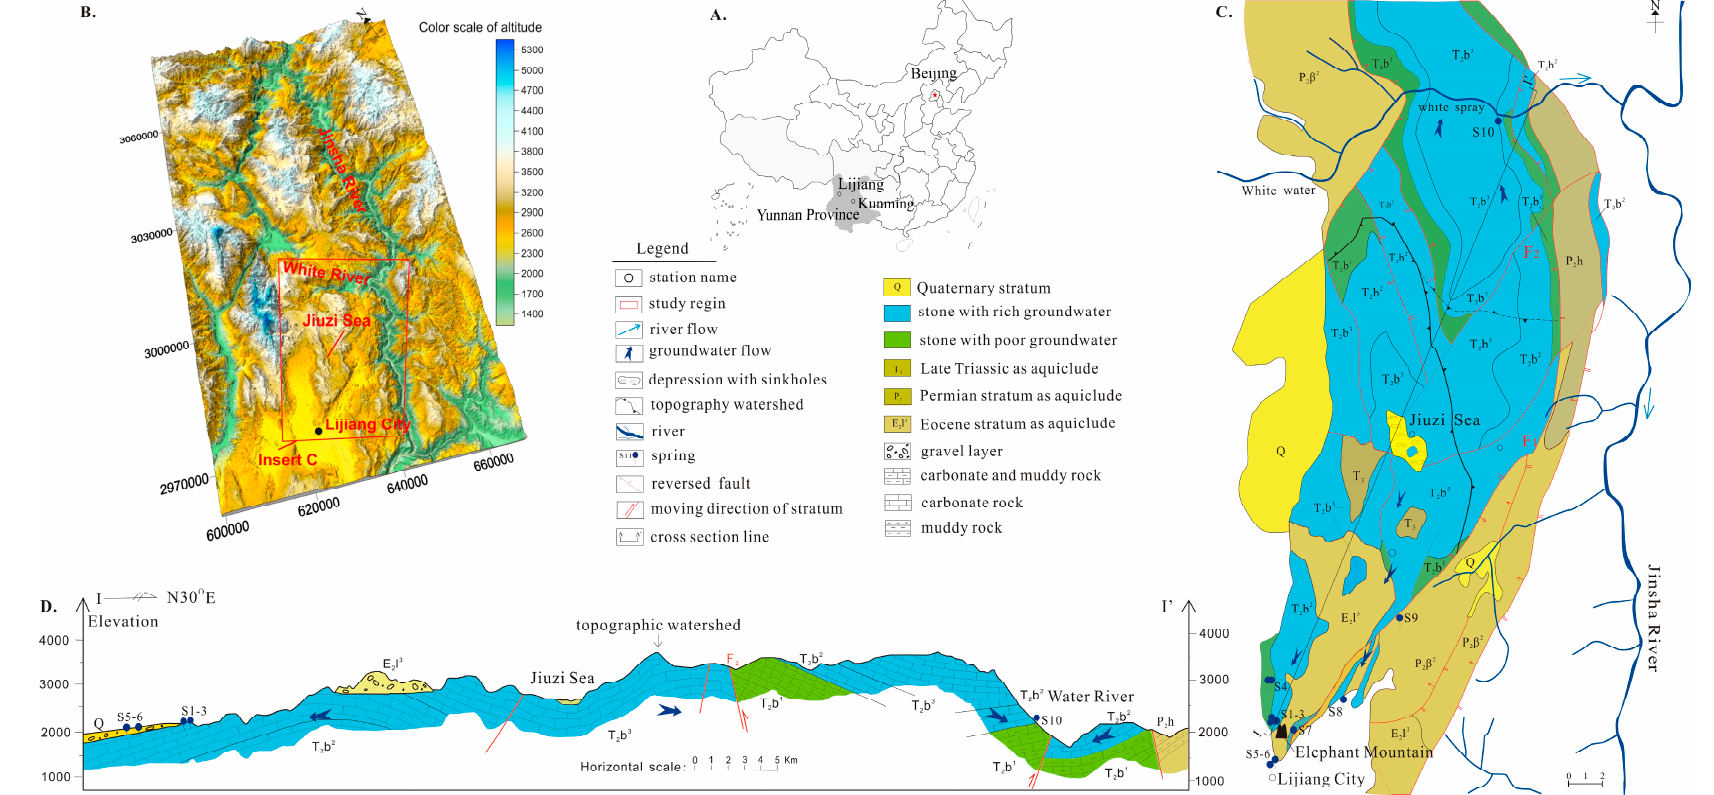
Figure 1. The location of the study area and the sketch of hydrogeological environment the location of Lijiang; ( A ) the location of Lijiang in China; ( B ) the range of the studied area; ( C ) the sketch of hydrogeological environment of the study area; and ( D ) the hydrogeological cross section of I-I’ (the cross section line is shown in ( C )).